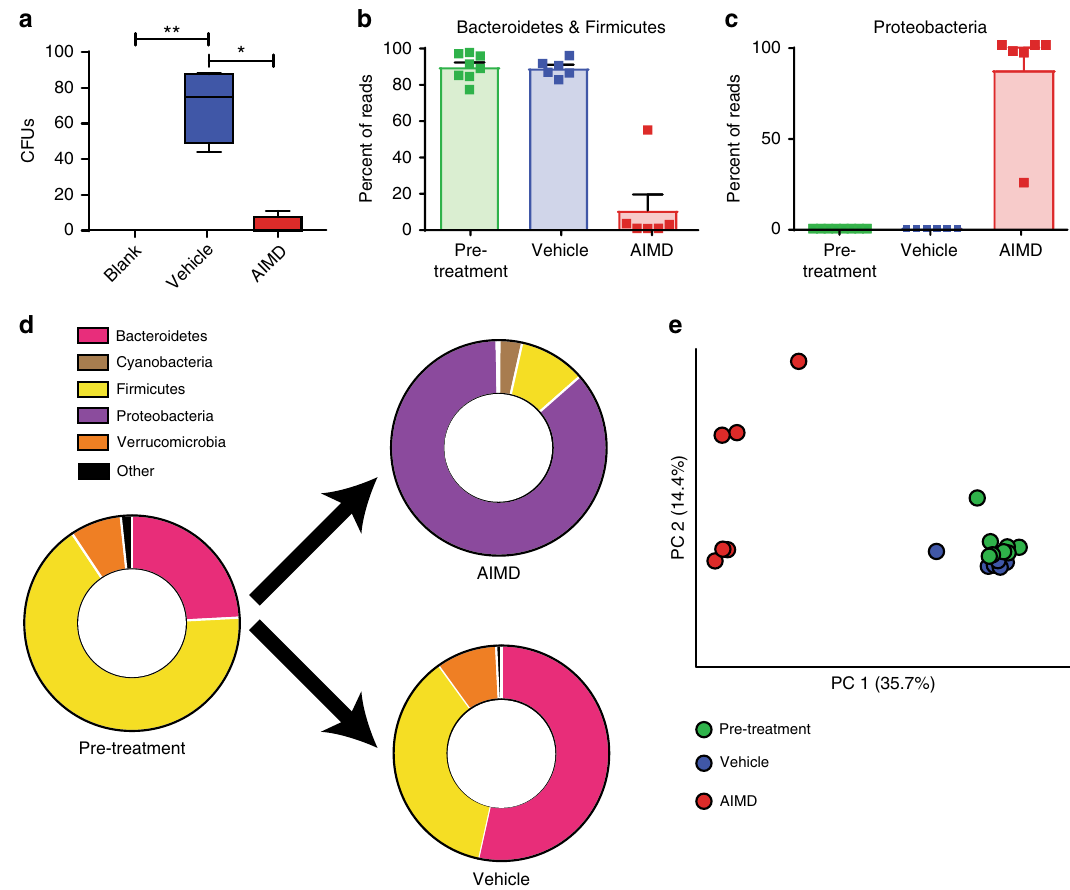
Fig. 1 AIMD depletes the gut microbiome. a Stool cultures from AIMD mice yielded fewer colonies, n = 5/group. For box plot, center is mean, box is 25th to 75th percentile, and whiskers are 5th to 95th percentile. Kruskal – Wallis test, * p < 0.05, ** p < 0.01. b , c 16S results show that AIMD mice had a decrease in OTUs detected from the Firmicutes and Bacteroidetes phyla, and an increase in Proteobacteria phyla, n = 6 – 8/group, mean percent abundance (with SEM). These differences were signi fi cant as assessed by ANCOM 24 . d 16S results showing the shifts in microbiome in each treatment condition. e Principal coordinate analysis of the gut microbiome, n = 6 – 8/group. Fecal specimens were collected approximately 2 weeks after